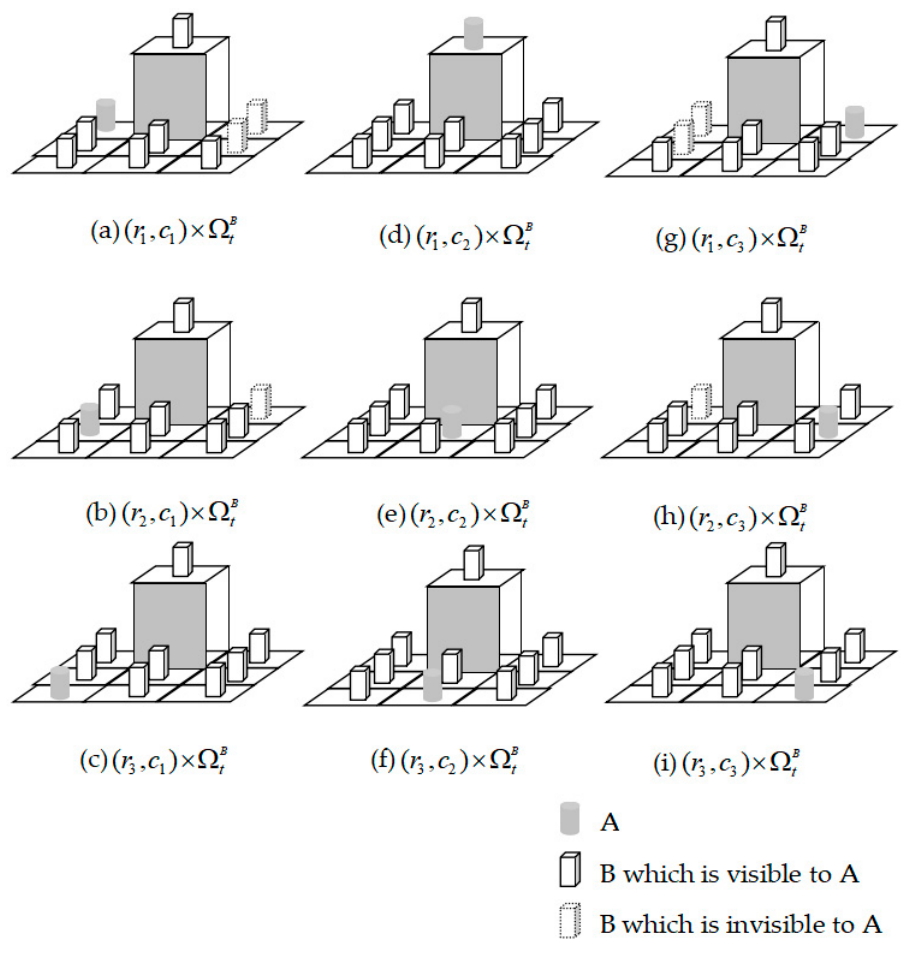
Figure 4. Discretized representation of a four-dimensional sample space.